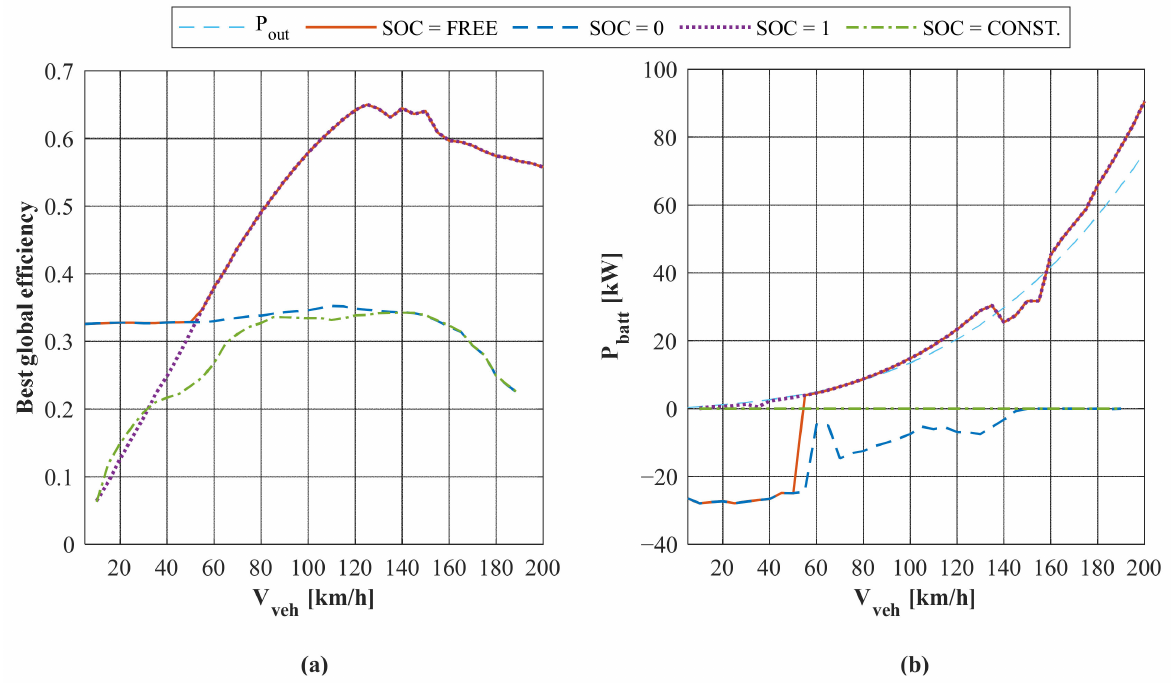
Figure 6. ( a ) Best global efficiency in power-split operation; ( b ) battery power in the optimal power-split operating